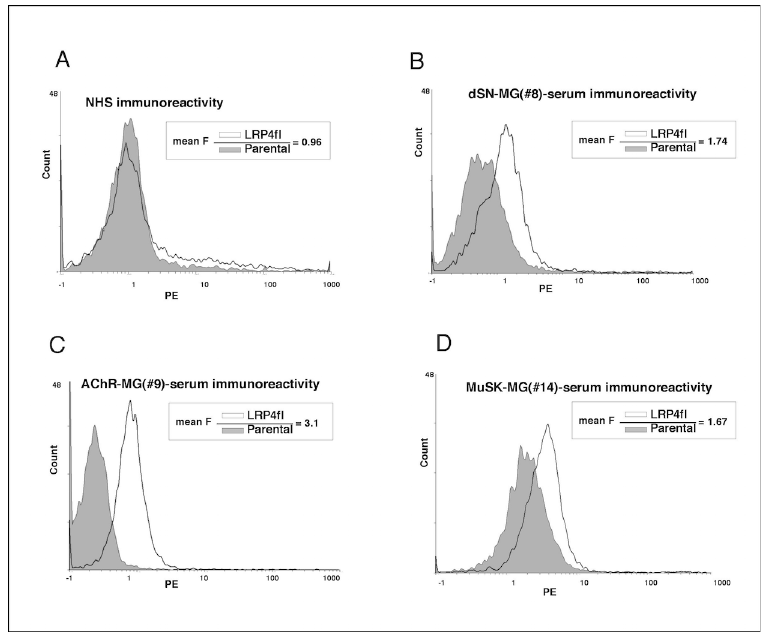
Fig 2. Anti-LRP4 detection by FACS analysis. Each of 101 MG s and 85 control sera was tested on both parental untransfected (shaded area) and on LRP4fl-HEK293T transfected cells (full line). None of the 45 NHS but only 14 MG sera showed a clear cut shift of mean fluorescence value with a ratio transfected/ untransfected > 1.5. We show the immunoreactivity of one NHS, one dSN-MG (sample#8), one AChR-MG (sample#9) and one MuSK-MG serum (sample#14) (A,B,C,D respectively) as representative plots.